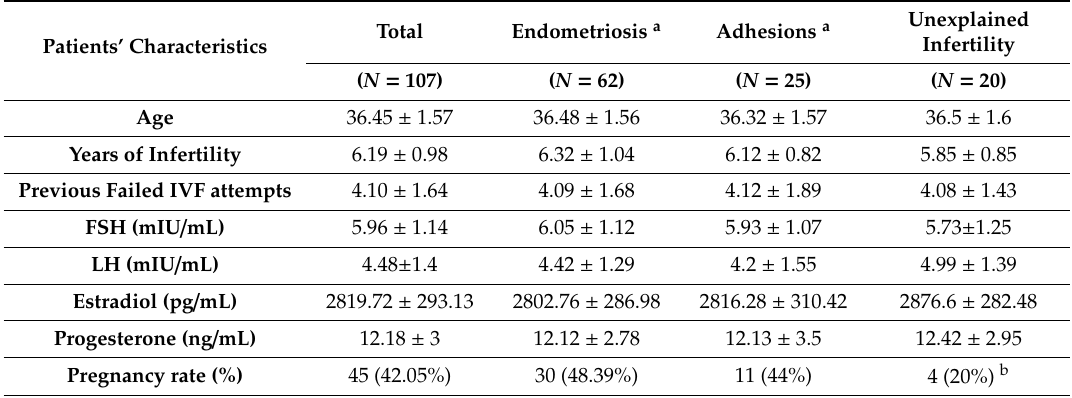
Table 2. Mean ± standard deviation of patients’ age and hormonal levels as well as pregnancy rates for the patient cohort along with the three subgroups according to laparoscopy diagnosis.